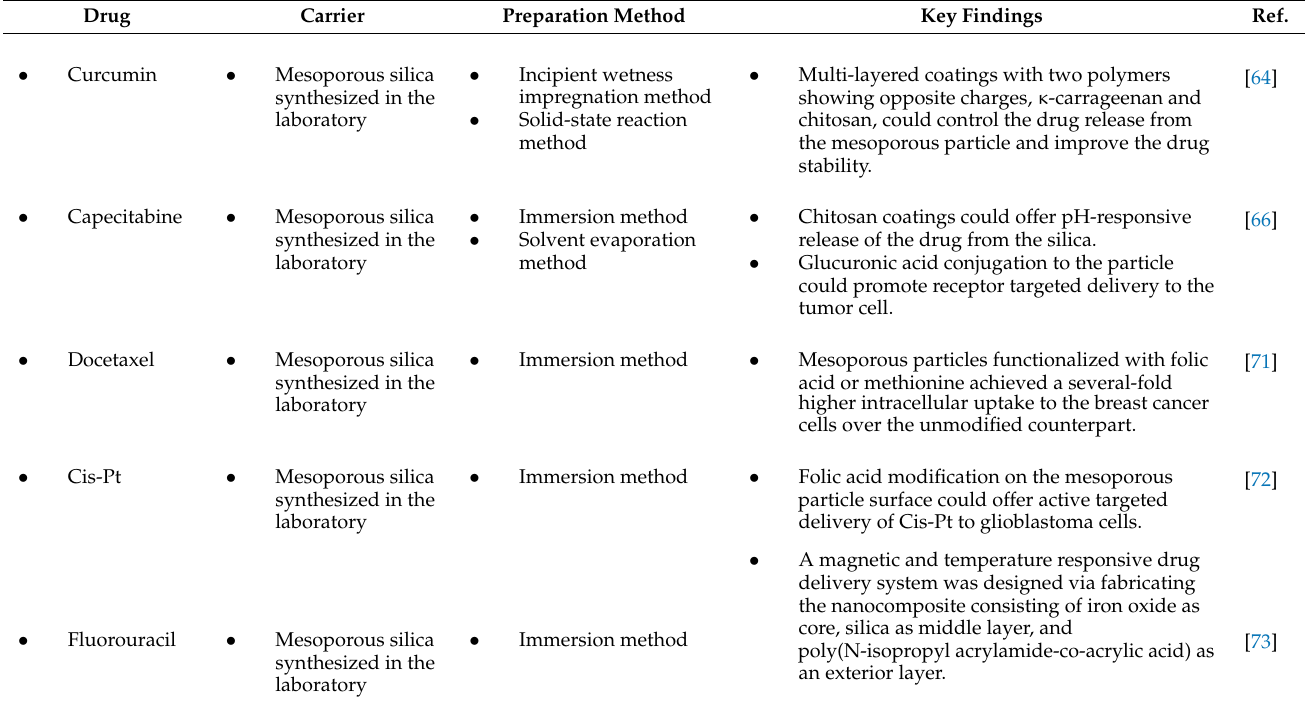
Table 6. Recent examples of surface modification strategies for mesoporous particle-based amorphization. Drug Carrier Preparation Method Key Findings